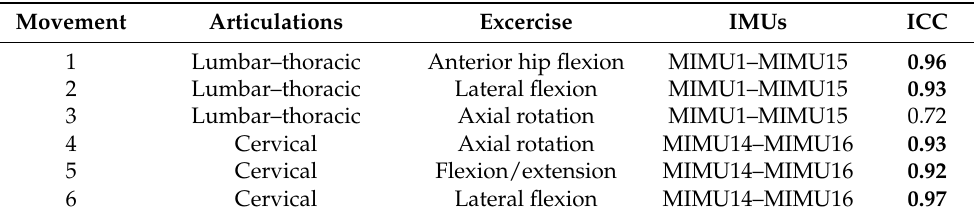
ICC scores highlighted in bold indicate an excellent level of reproducibility of the system for the corresponding